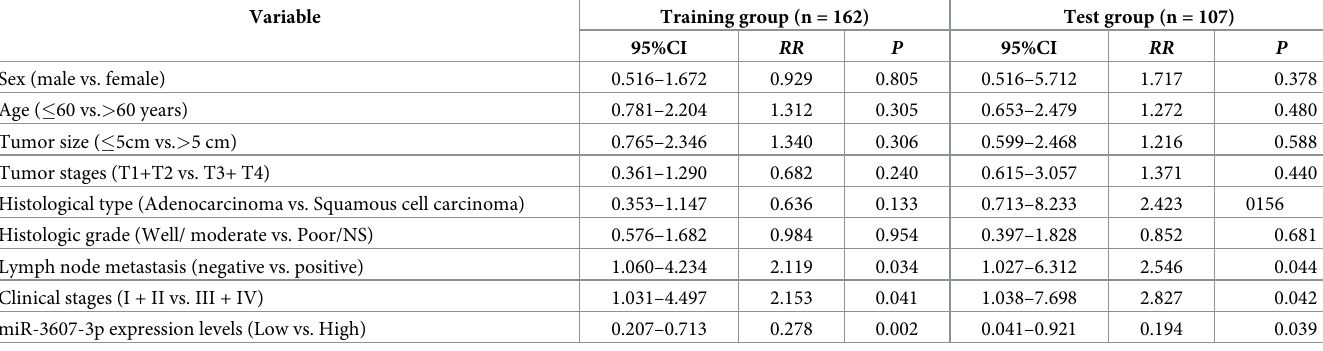
Table 2. Multivariate cox regression analysis of factors associated with overall survival in